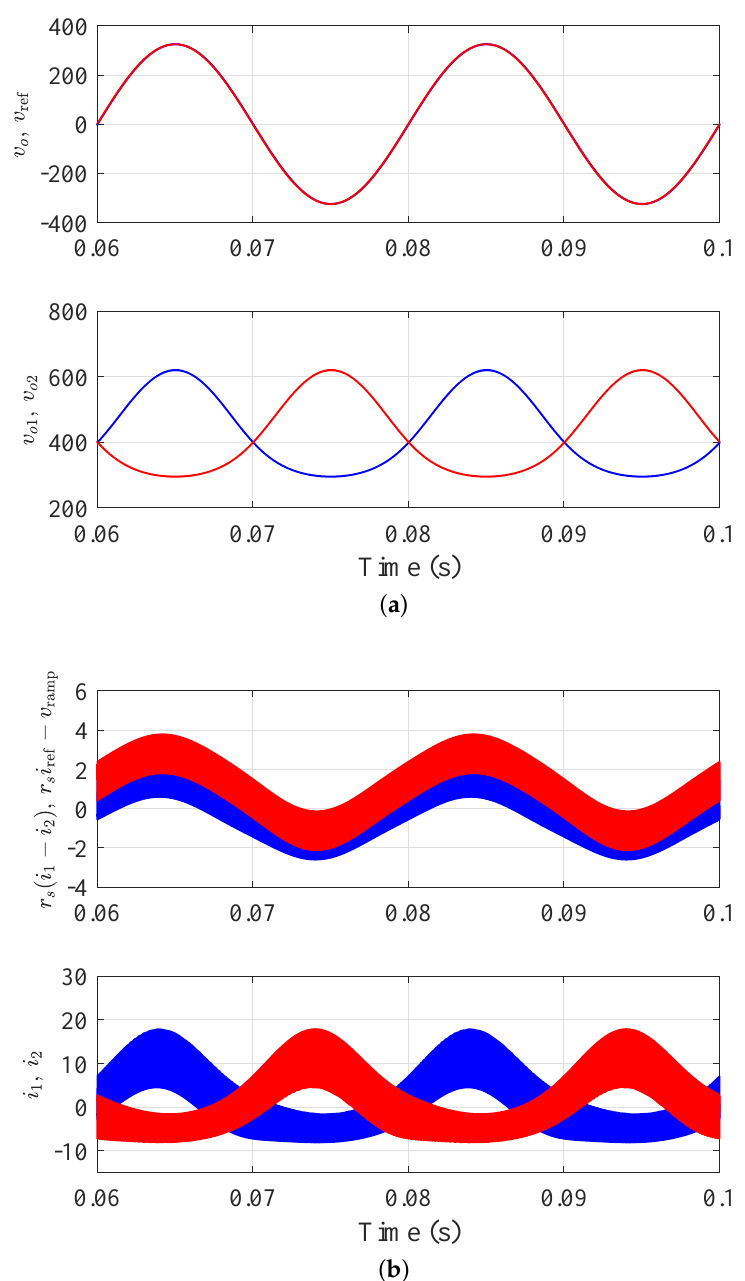
Figure 2. Steady-state response of boost inverter with k p = 0.2 and V M = 2 V. ( a ) Capacitor voltages v o 1 and v o 2 , output and reference voltages v o and v ref . ( b ) Inductor currents i 1 and i 2 and control signals r s ( i 1 i 2 ) and r s i ref v ramp . For each subplot, traces correspond to the shown voltages in [V] and currents − − in